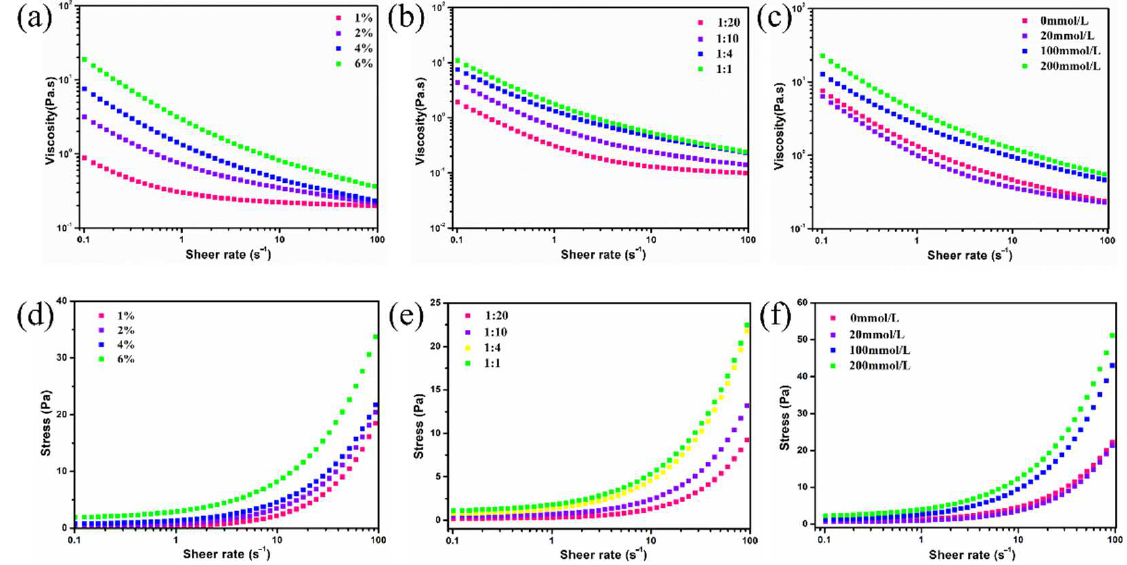
Figure 5. Viscosity ( a – c ) and shear stress ( d – f ) of OS/β-lg complex stabilized emulsions at different particle concentrations, oil/water ratios, and ionic strengths.